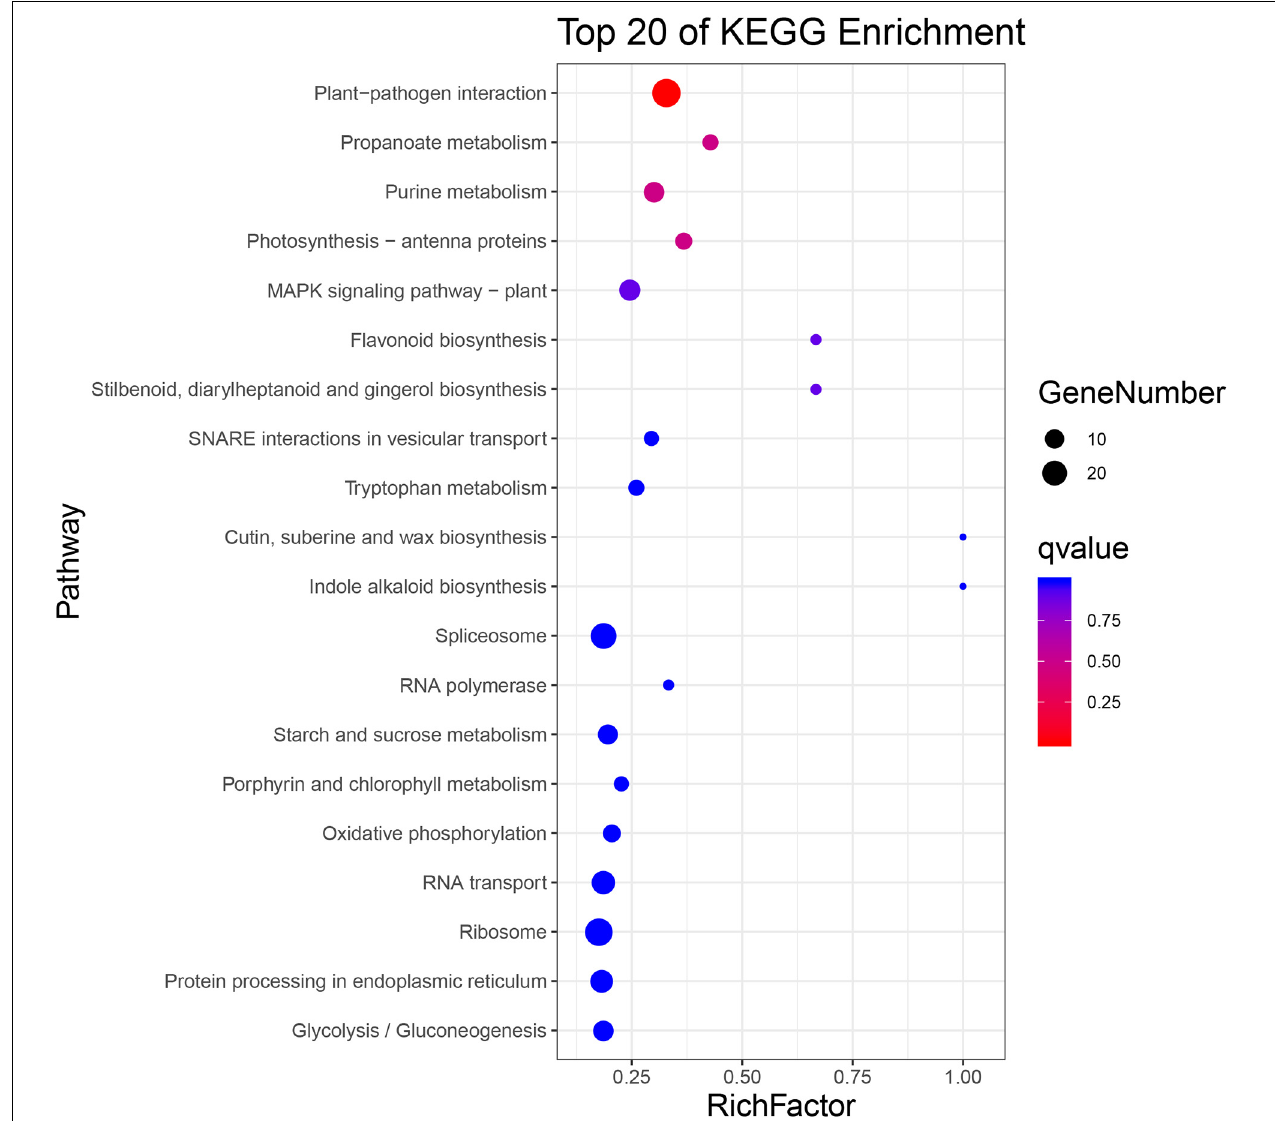
FIGURE 5 | KEGG enrichment analysis of significantly changed